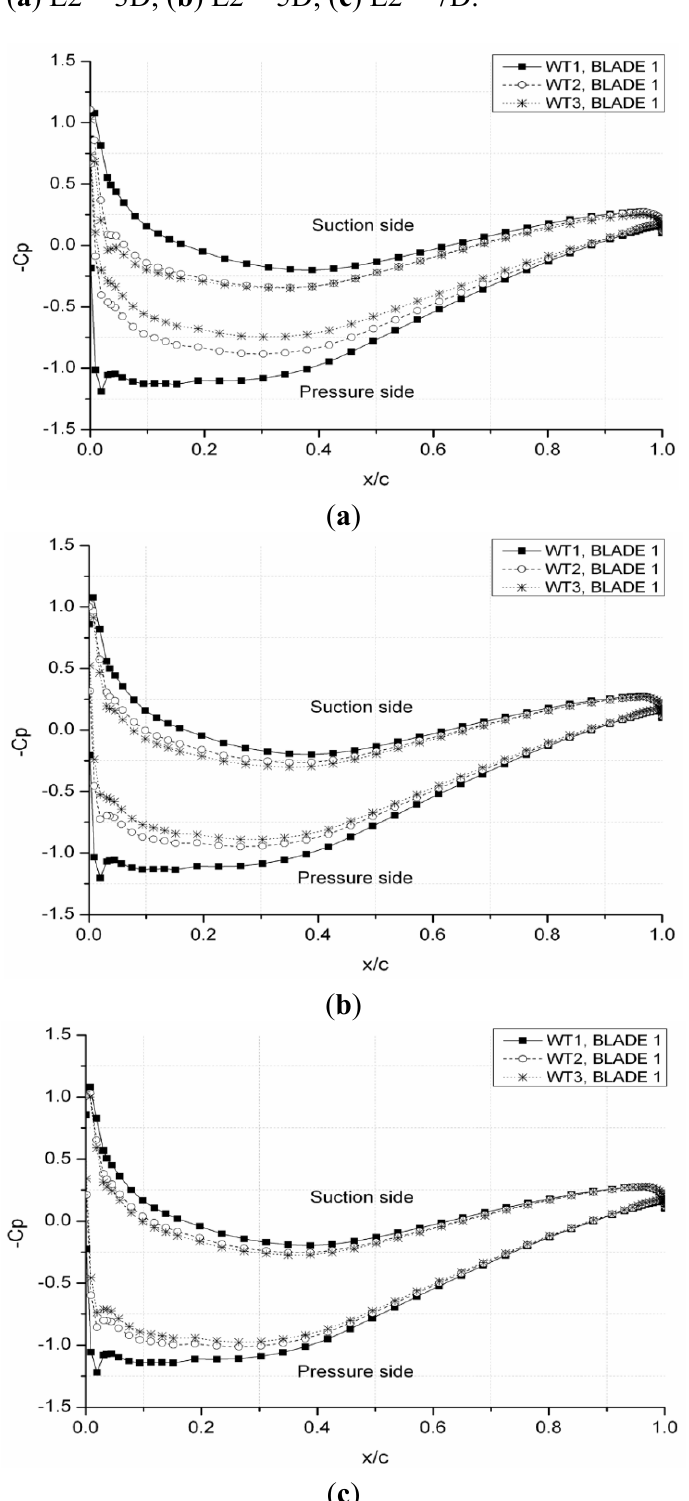
Figure 10. Pressure coefficient distributions at μ = 0.8 on the wind turbine blade (NACA 63-418). ( a ) L2 = 3D; ( b ) L2 = 5D; ( c ) L2 =